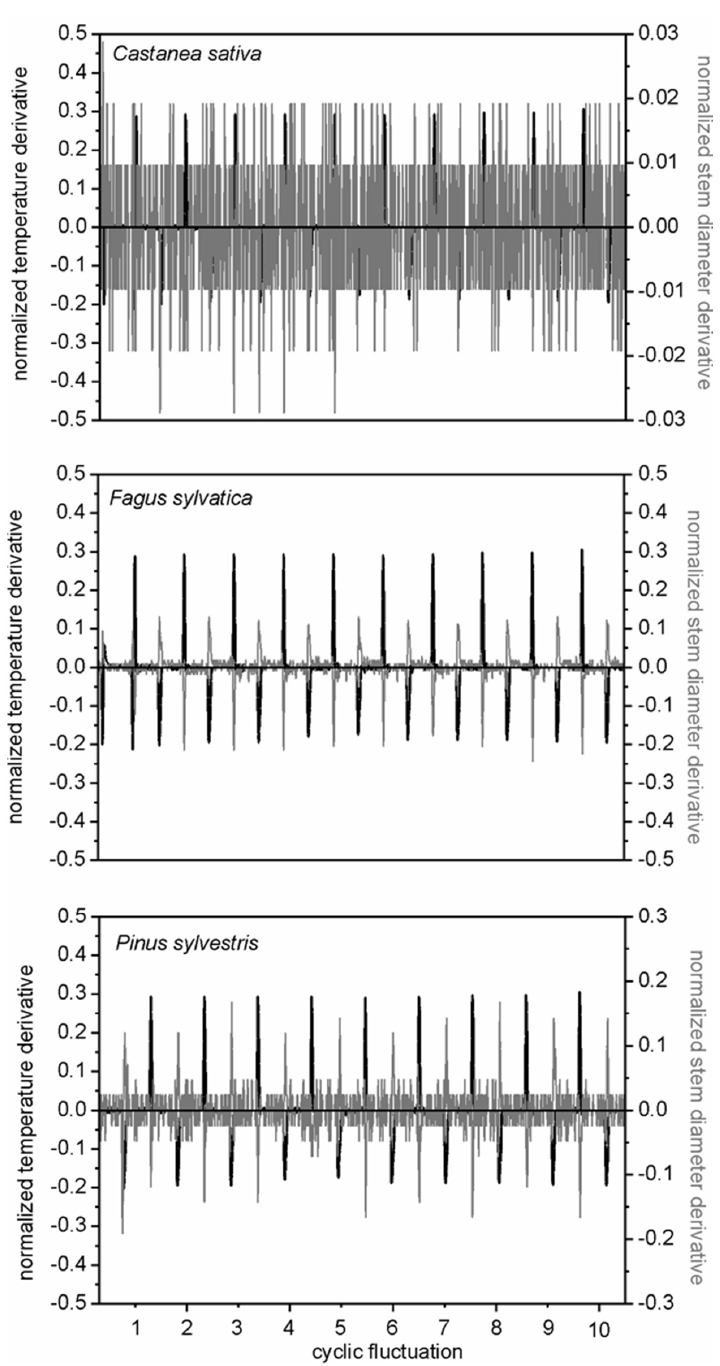
Figure 4. Normalized derivative of temperature (black line) and stem diameter (grey line) of C. sativa , F. sylvatica and P. sylvestris logs exposed to cooling test, showing detail of ten repeated cooling cycles.